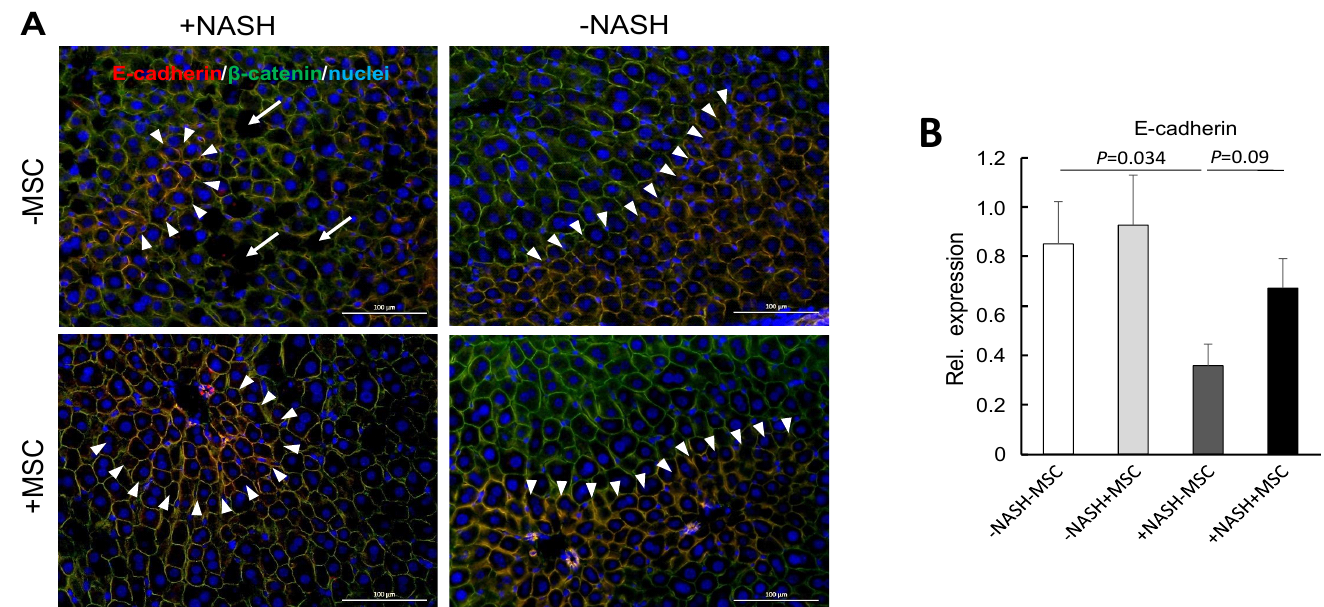
Figure 6. MSC treatment restores tissue homeostasis in livers of high-fat-diet-fed mice; ( A ) E-cadherin (red) and β -catenin (green) were detected by fluorescent immunohistochemistry in liver slices from animals either fed the high fat diet (HFD) or not (ND); where indicated, mice were treated with human MSC (+MSC) or left untreated ( − MSC); pictures are representative for 3 different animals out of each group (orig. magnification: 20 × ; Scale bar—100 µ m); white arrowheads demarcate zonal co-expression of E-cadherin and β -catenin (yellow = red/green overlay) in periportal hepatocytes, while β -catenin is expressed pan-parenchymally; blue, nuclear stain with DAPI. White arrows indicate “holes” of lipid deposition in the NASH livers; ( B ) quantification of E-cadherin mRNA abundance by sqRT-PCR; expression was normalized to the expression of β 2-microglobulin used as a housekeeping gene; values are means ± SEM from 3 (ND − MSC), 4 (ND + MSC), 6 (HFD − MSC) and 6 (HFD + MSC) animals per group; one-way ANOVA and LSD post hoc test to calculate significance between